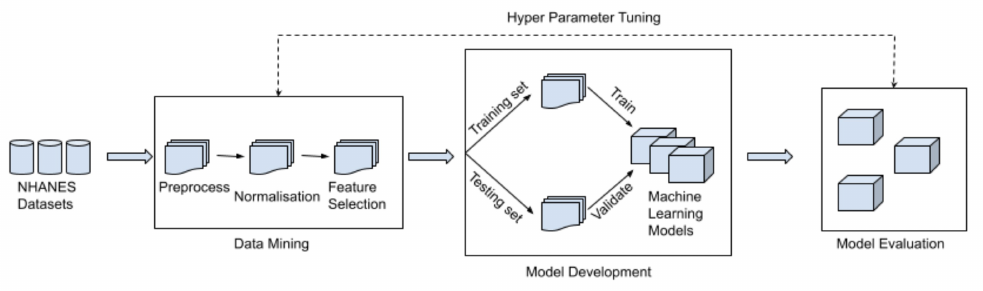
Figure 1. Workflow of the